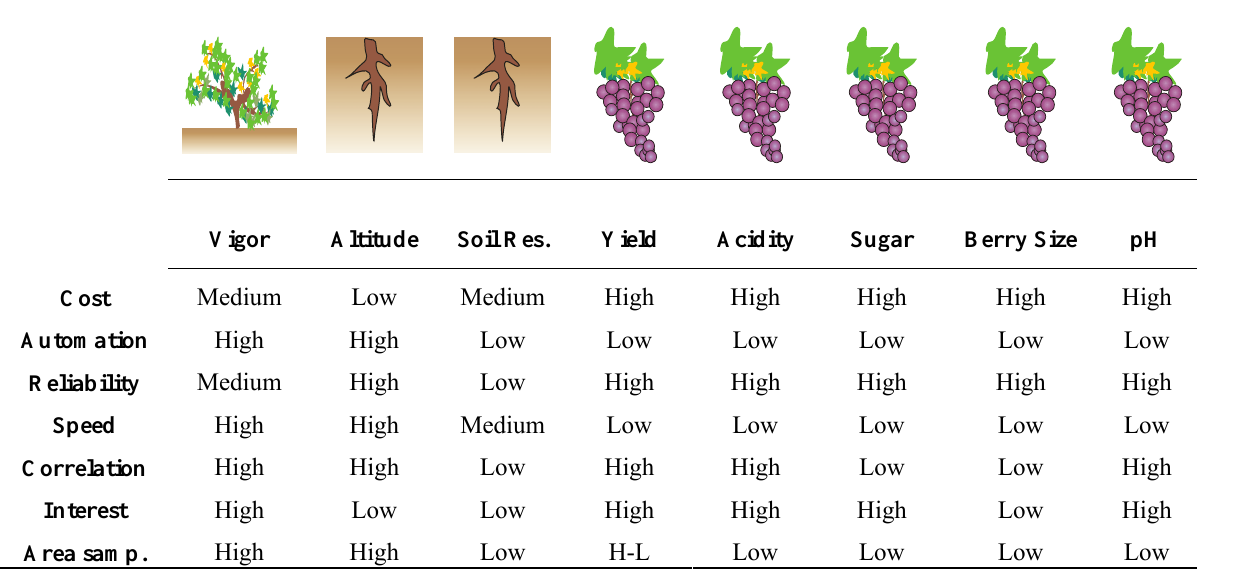
Table 1. Selection of crop biometric traits for wine production vineyards.